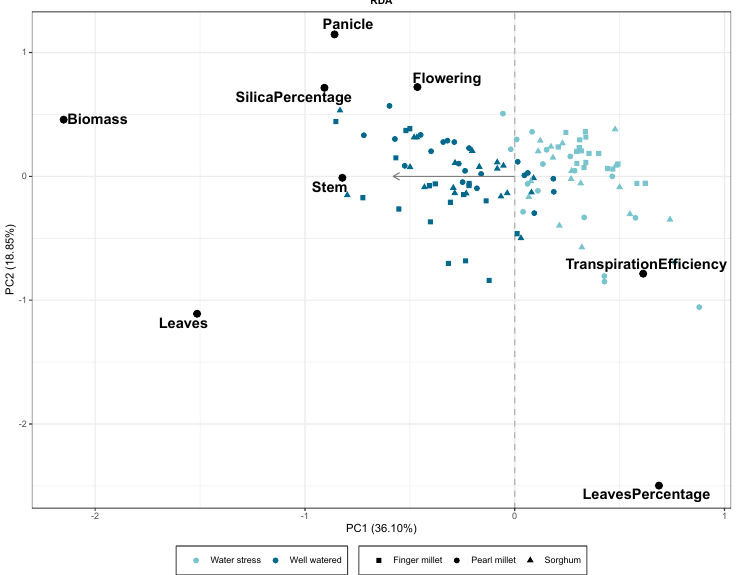
Figure 6. Triplot showing the results of the redundancy analysis. Gray arrow represents the ex- planatory variable (water treatment), black dots represent the variables included in the analysis (physiological parameters and biosilica accumulation), and blue spots indicate the samples which correspond to the single plant. Light blue = WS and blue = WW. Triangle = sorghum, circles = pearl millet, squares = finger